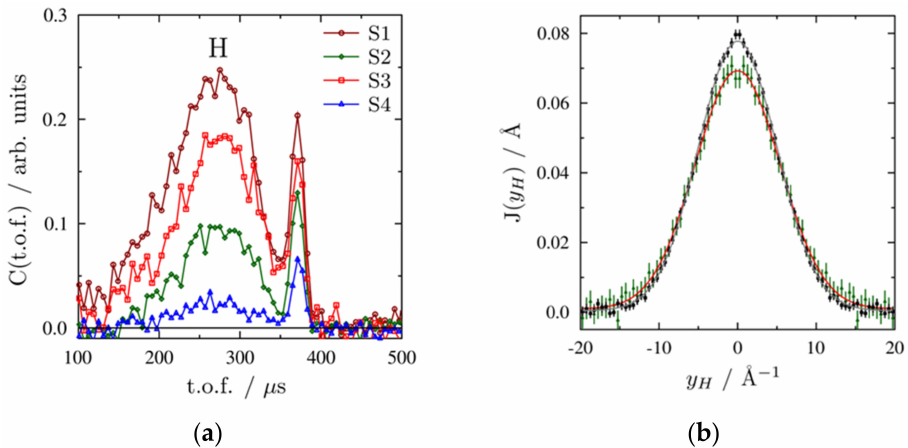
Figure 5. ( a ) DINS spectra of samples S1, S2, S3, and S4 in the time − of − flight domain. ( b ) Corrected H NCP in sample S1 (green error bar) together with its best fit (red line) and compared to the hydrogen NCP in